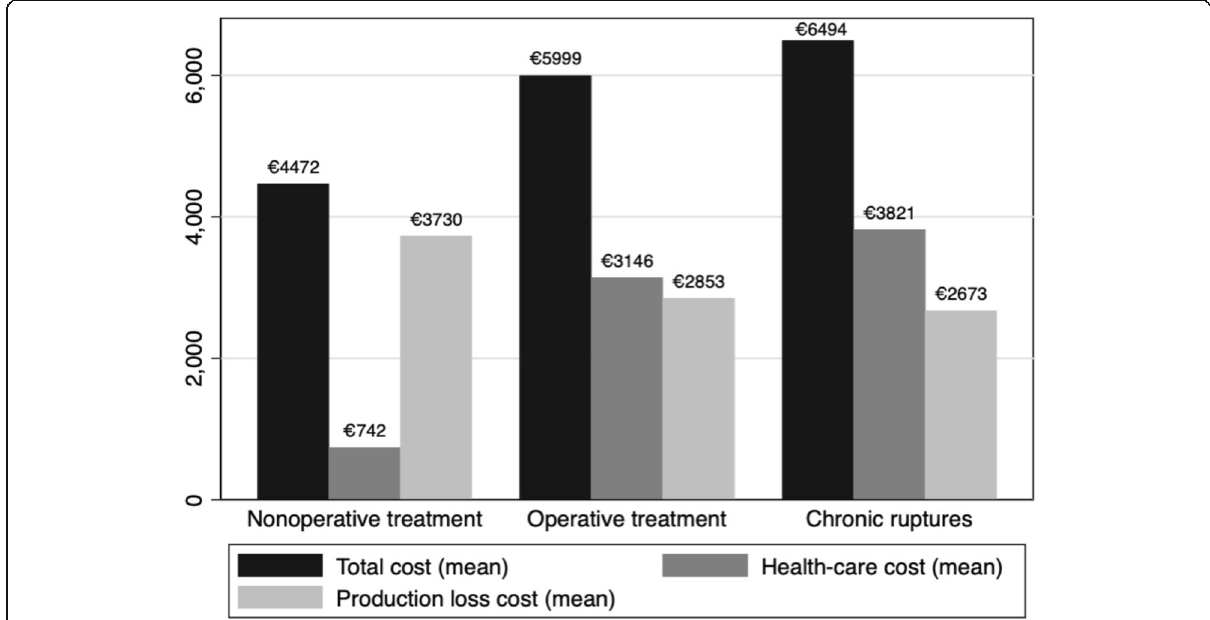
Fig. 1 Diagram depicting the differences in health-care, production-loss and total costs (EUR) of chronic and the surgical and non-surgical treatment of acute Achilles tendon